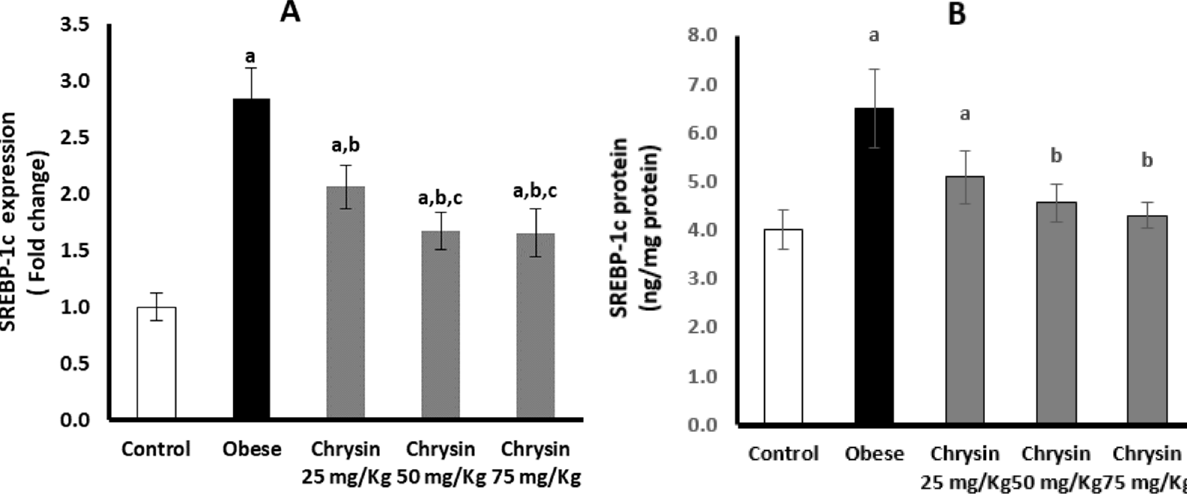
Figure 3. Changes in the hepatic expression of SREBP-1c at mRNA ( A ) and protein ( B ) levels in the obese rats untreated or treated with different doses of chrysin. Data presented as Mean ± SD. a, significantly different from the control group; b, significantly different from the obese group; c, significantly different from the group treated with chrysin 25 mg/kg, using ANOVA and p <